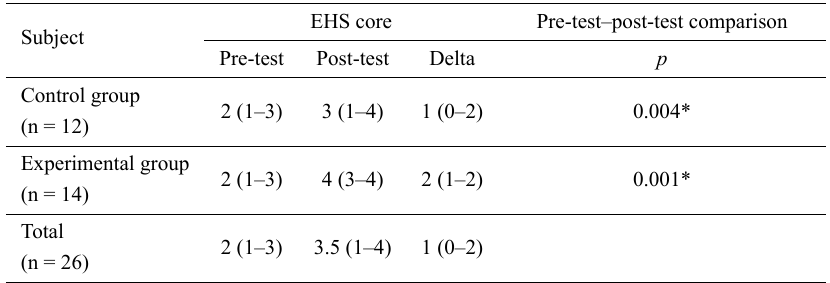
Table 3. Comparison of EHS scores.